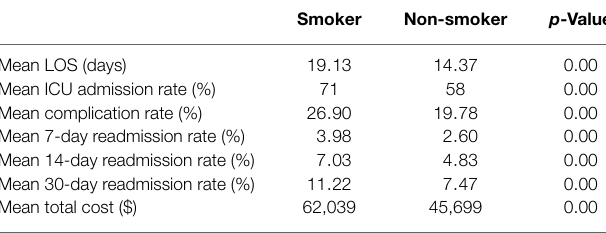
TABLE 2 | Outcomes of patients admitted for spinal treatment for fracture . Smoker